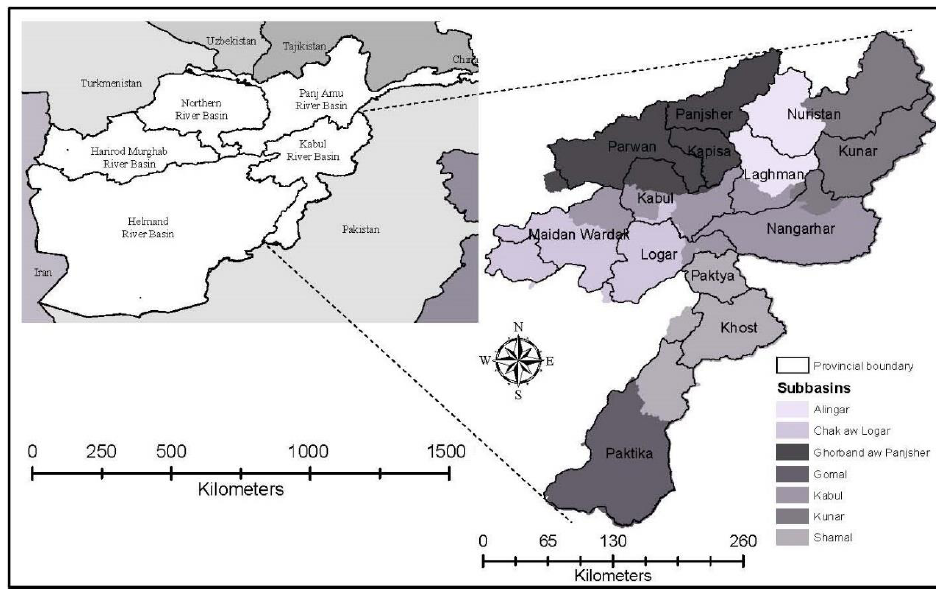
Figure 1. Location of the Kabul River Basin with its sub-basins and provincial.